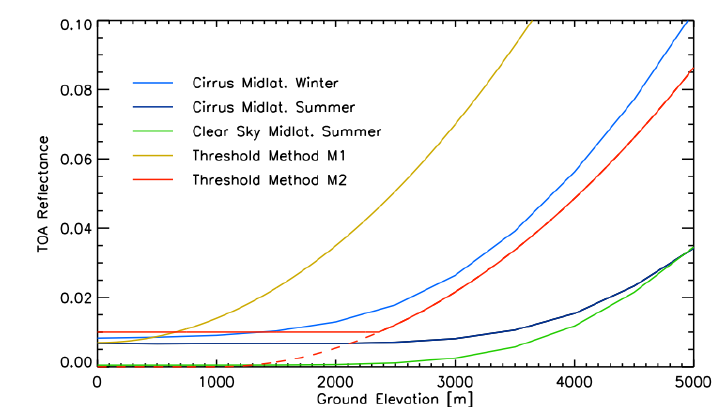
Figure 1. Top-of-atmosphere (TOA) reflectance in the 1.38 µ m band simulated for Sentinel-2 based on MODTRAN5 runs, compared with the two discussed empirical cirrus detection threshold functions (M1 and M2). The dashed line is the function used for cirrus